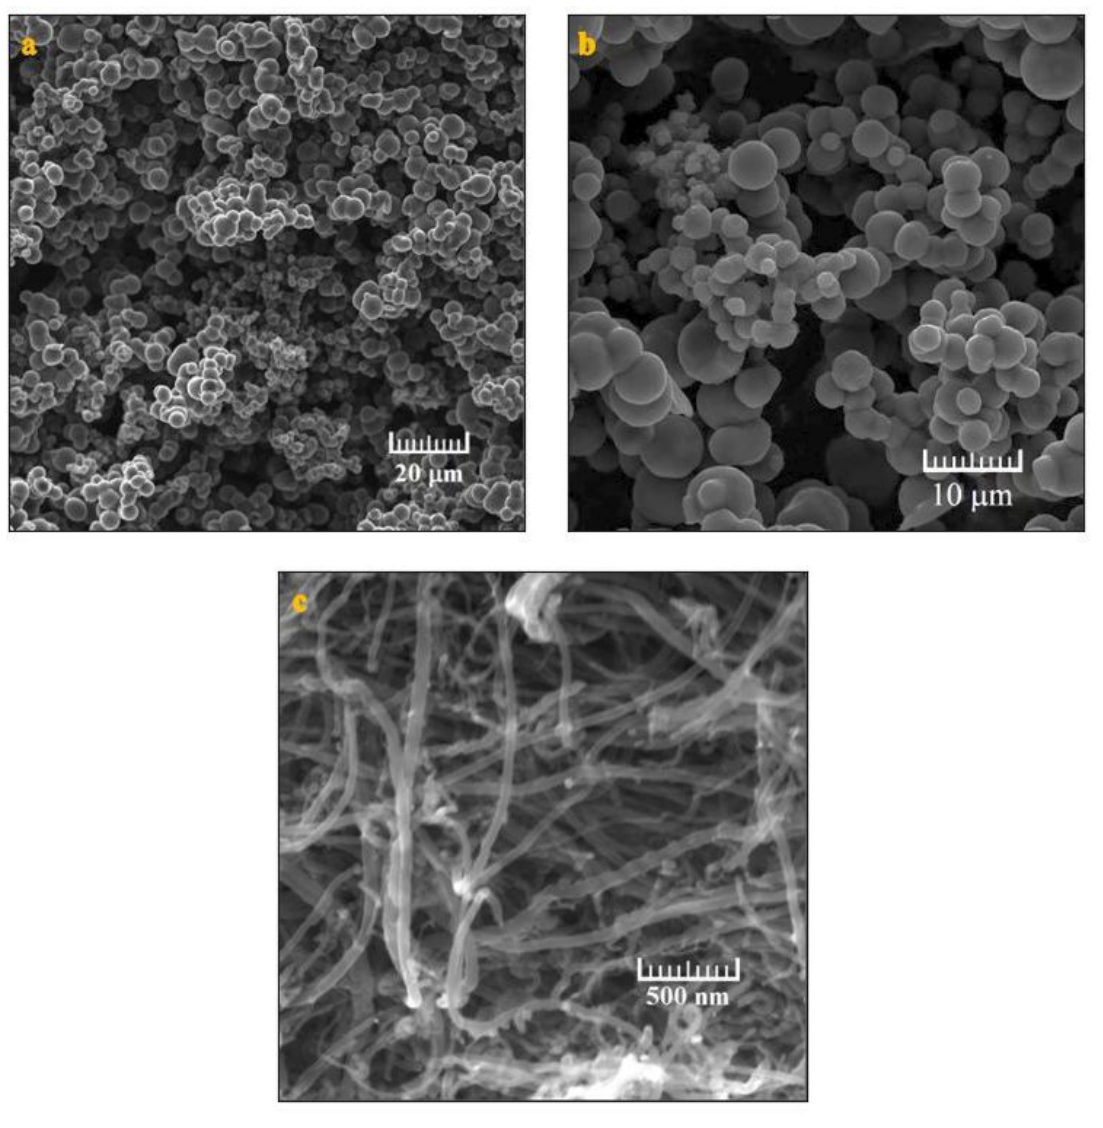
Figure 3. SEM images of: (a-b) CX (c) CNT.